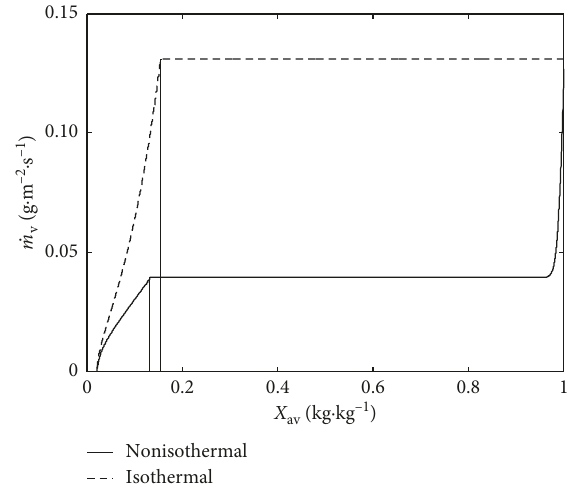
Figure 7: Isothermal and nonisothermal drying: drying rate